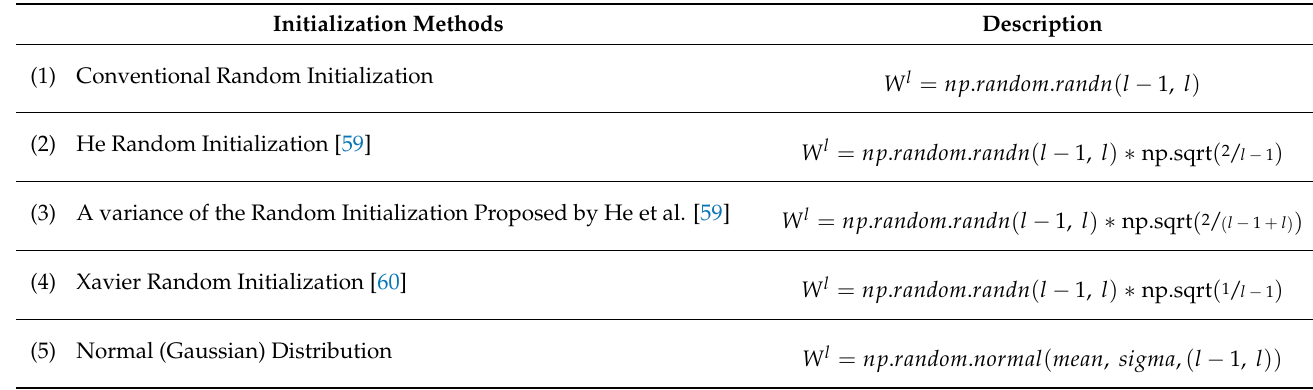
Table 2. Random Initialization